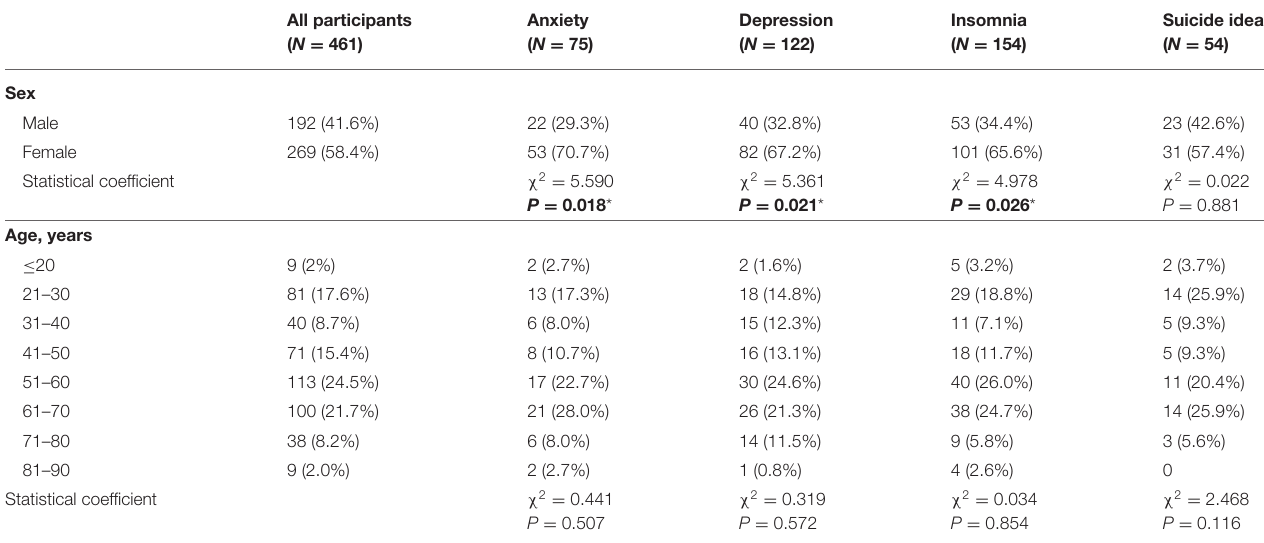
TABLE 3 | Sex, age, and psychological symptoms in COVID-19 patients.